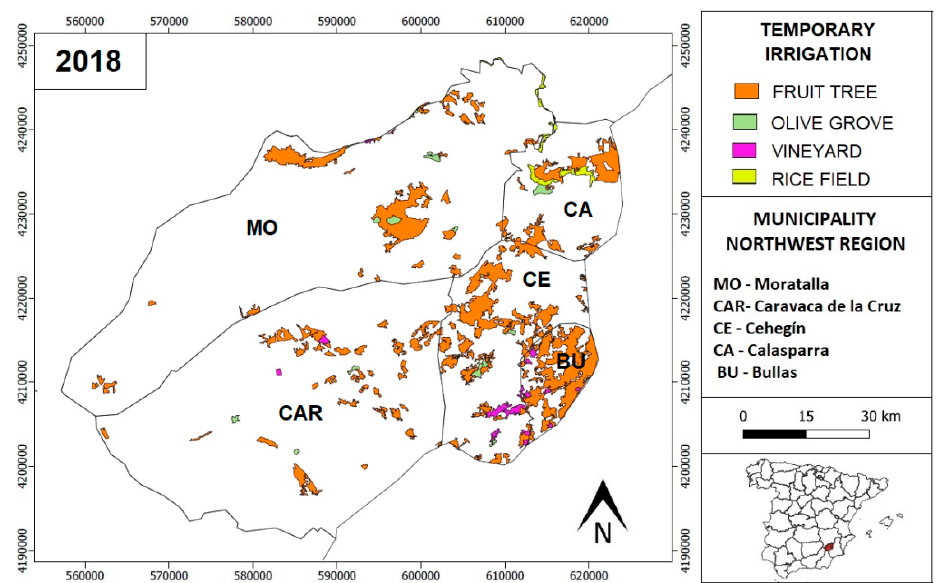
Figure 14. Spatial distribution of temporary irrigation crops (2018). Source: Authors.